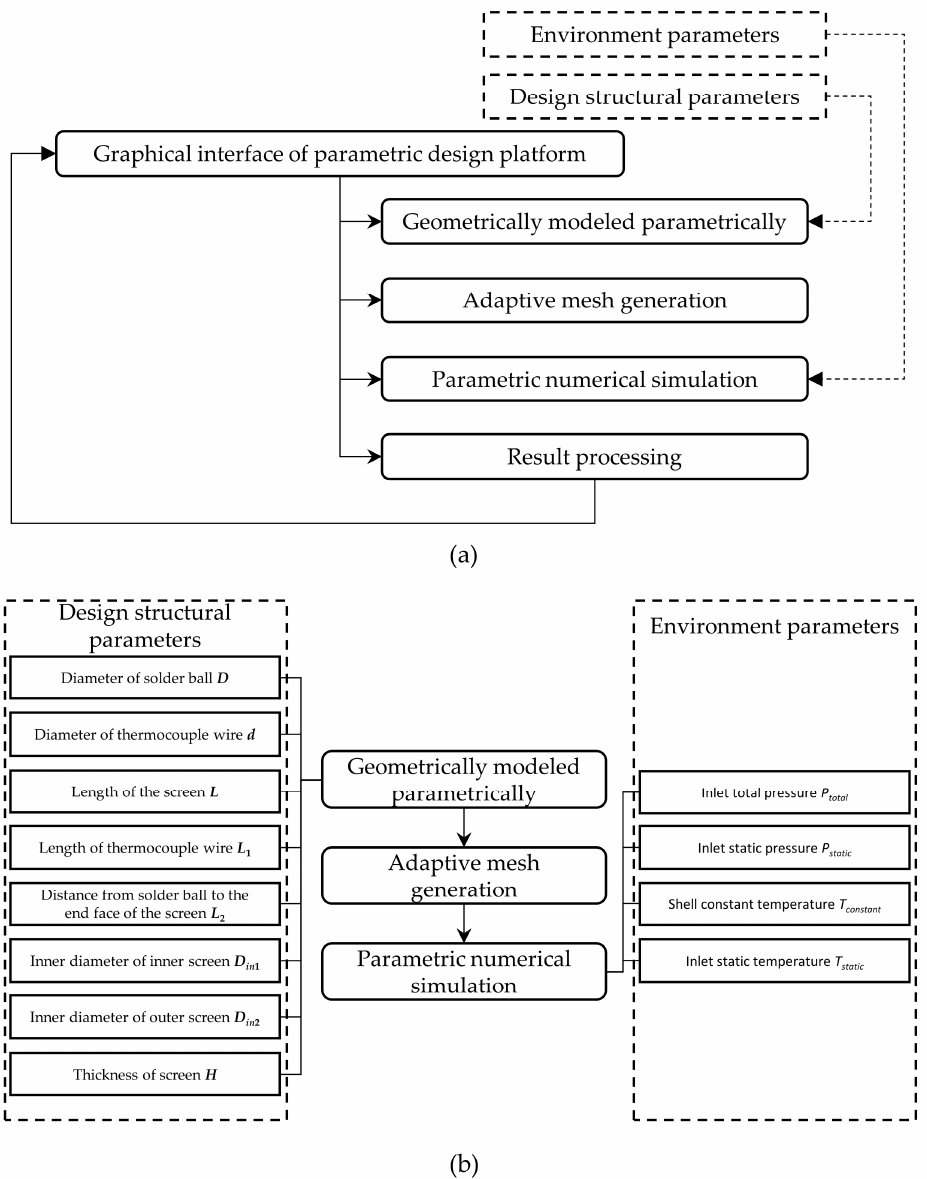
Figure 10. ( a ) Process framework for parametric design; ( b ) parameter types and classification in the parametric design process of dual-screen thermocouple (DST).